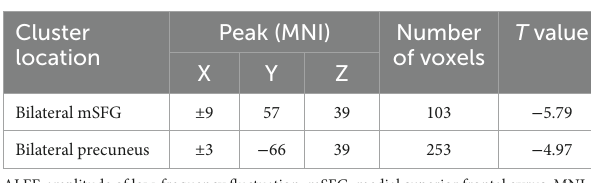
TABLE 2 Signification differences in ALFF values between the